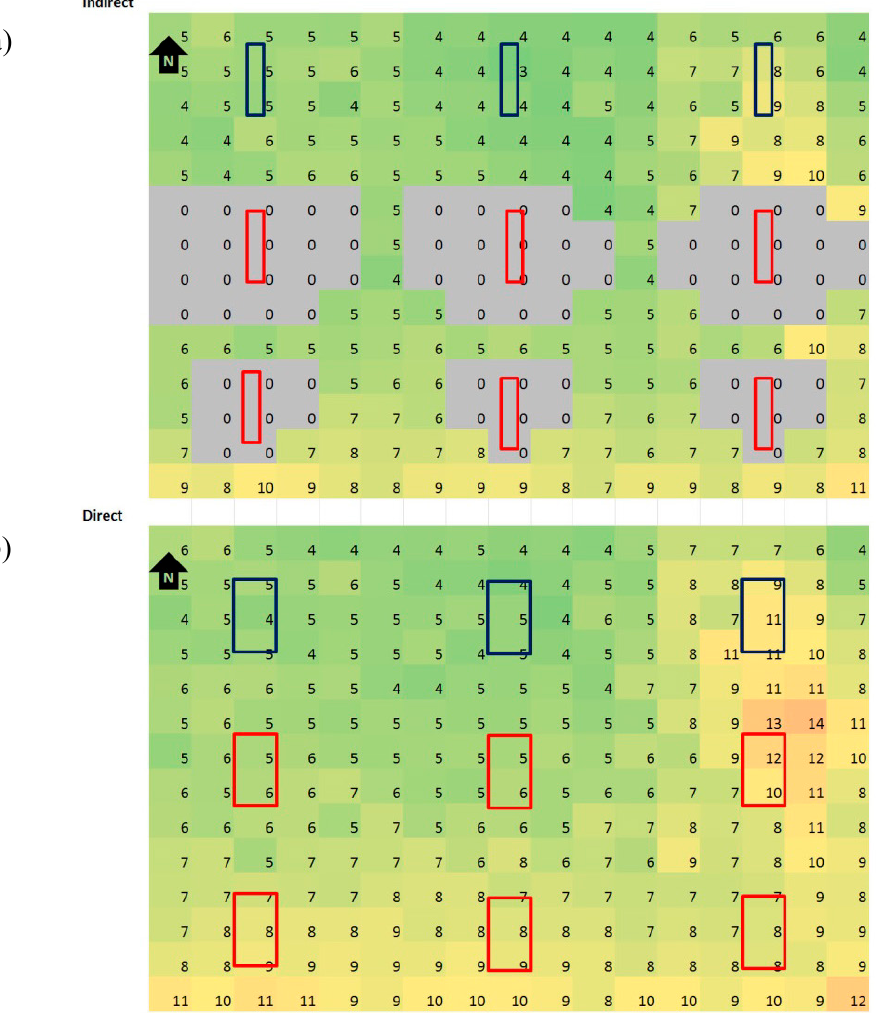
Figure 3. ( a ) Root-mean square error (RMSE) values across the ceiling for a relatively wide photosensor response function and indirect light; ( b ) RMSE values for a direct lighting system in the same